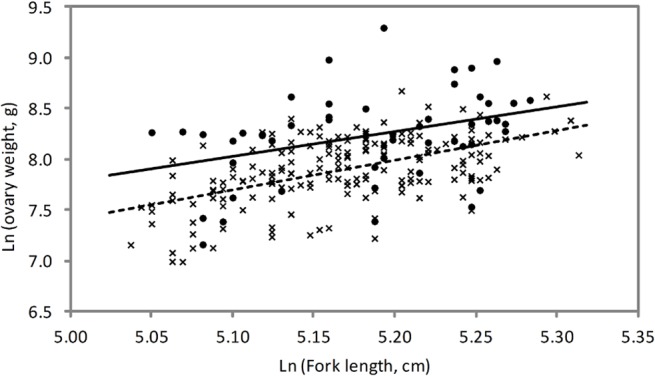
Relationship between ovary weight and fork length (natural log transformed) for southern bluefin tuna.Crosses/dotted line are ovaries with advanced yolked oocytes and new or <12 hour POFs (just spawned—after ovaries; n = 176), and dots/solid line are ovaries with hydrated oocytes without new POFs (about to spawn—before ovaries; n = 52).